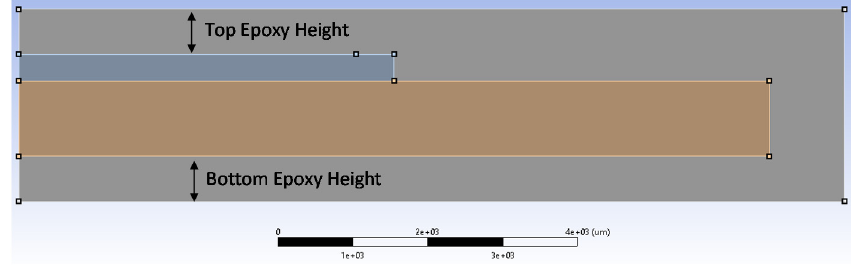
Figure 9. Dimension parameters for parametric analysis.